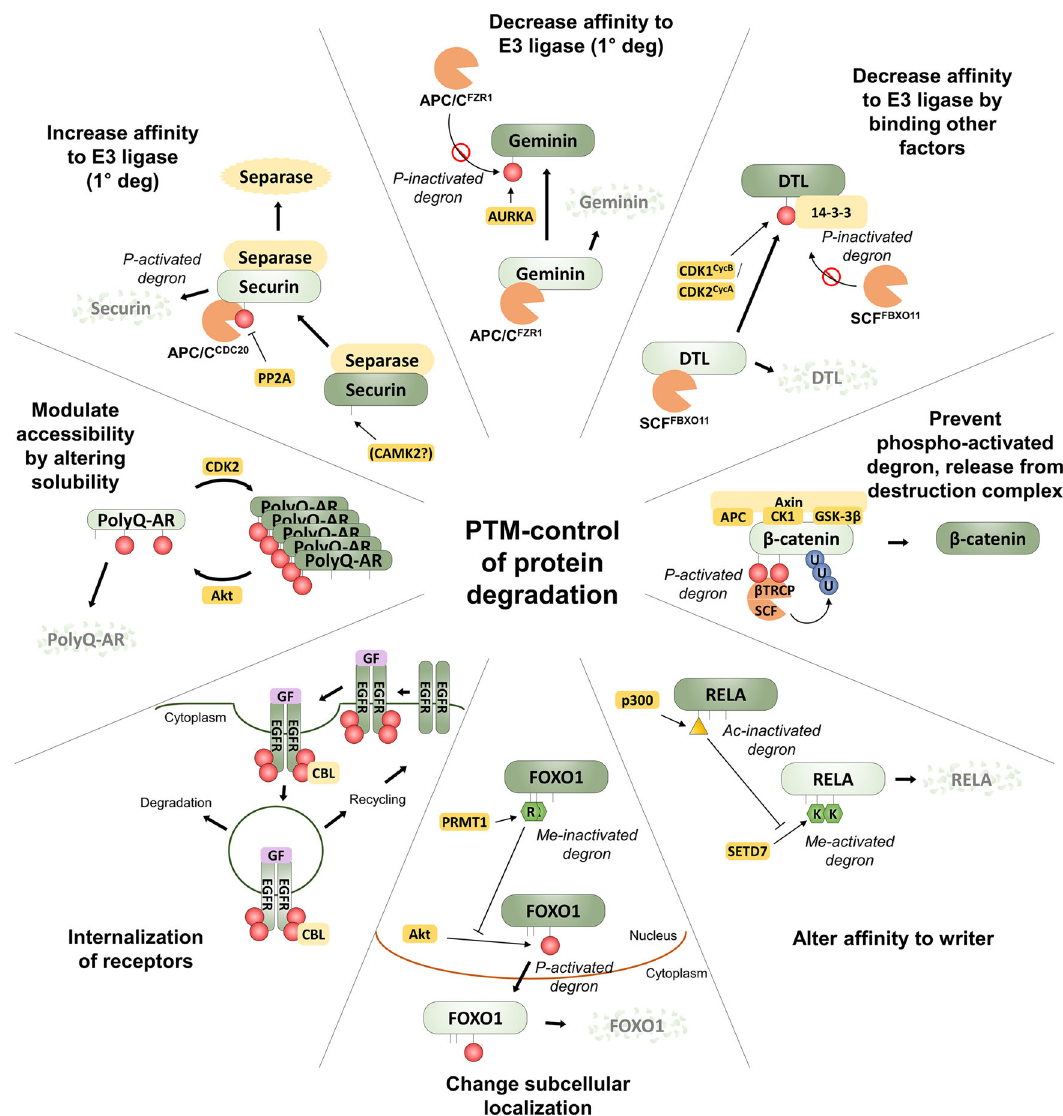
Fig. 3 | Diverse molecular mechanisms of PTM-control of protein degradation. VariousdifferentmolecularmechanismsforPTMs changing aprotein ’ sproteolytic stabilityhavebeenfound.DTL(forDenticlelessproteinhomolog,alsocalledCDT2)